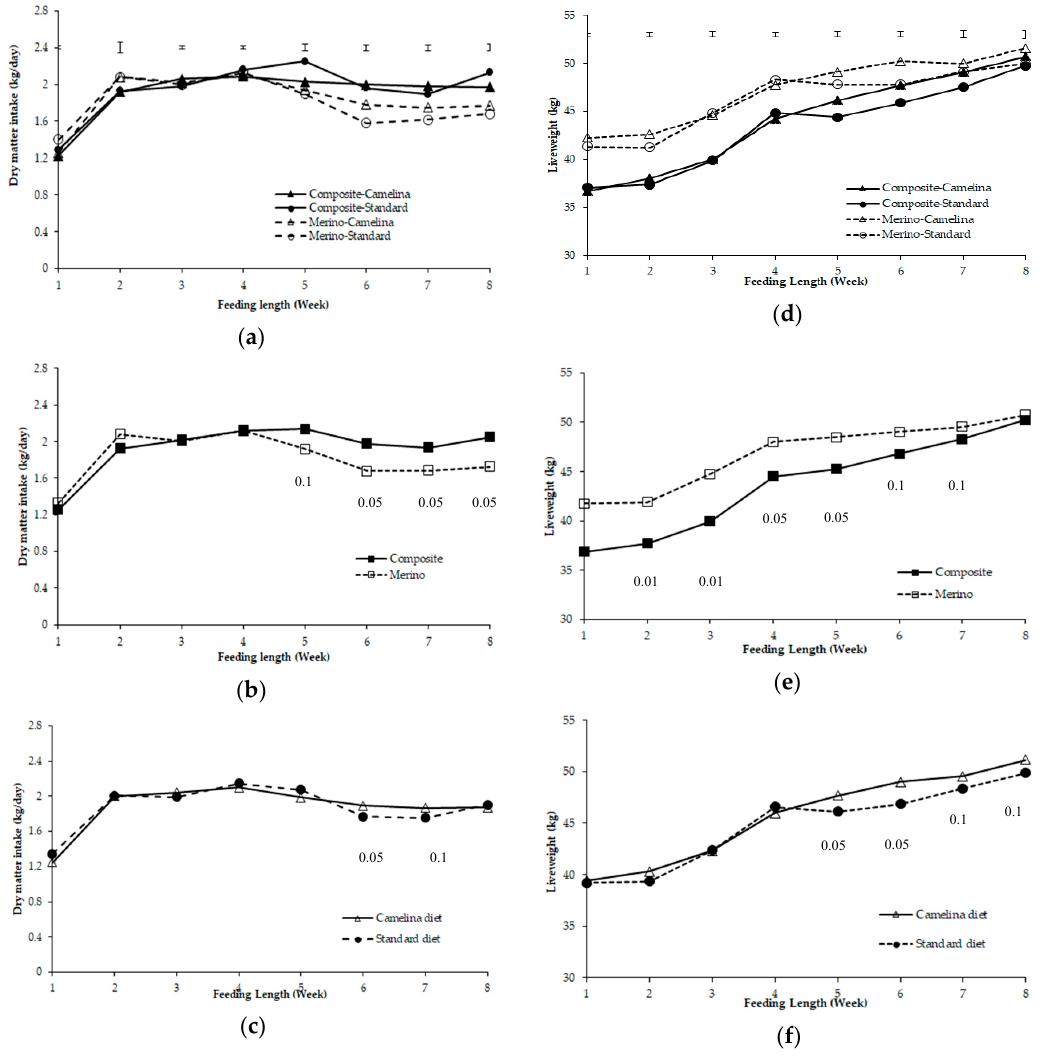
Figure 3. Weekly average dry matter intake ( a – c ) and weekly average liveweight ( d – f ) over the eight weeks experimental feeding. Values for breed × diet interactions of weekly average dry matter intake ( a ) and weekly average liveweight ( d ) and their main effects of breed ( b , e ) and diet ( c , f ) are presented. The error bars shown for breed × diet interaction on dry matter intakes and liveweights during weeks 1–8 feeding period represent standard error of difference at each point. The p -value for the test of significant difference between breed main effects and between diet main effects are provided within each figure.